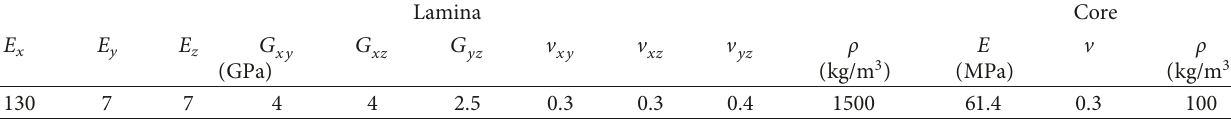
Table 1: Mechanical properties of the lamina and the core